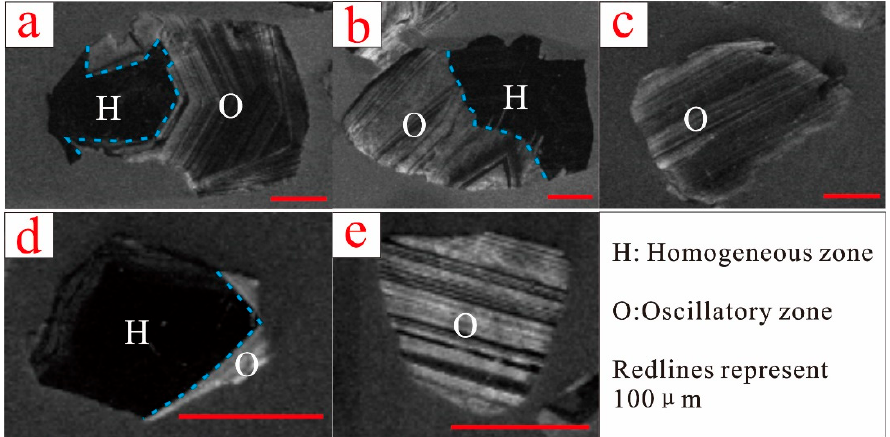
Figure 5. Representative CL images of cassiterites from different types of ores in the Xi’ao deposit. XA-3: ( a , b ); XA-4: ( c ); XA-5: ( d , e ).